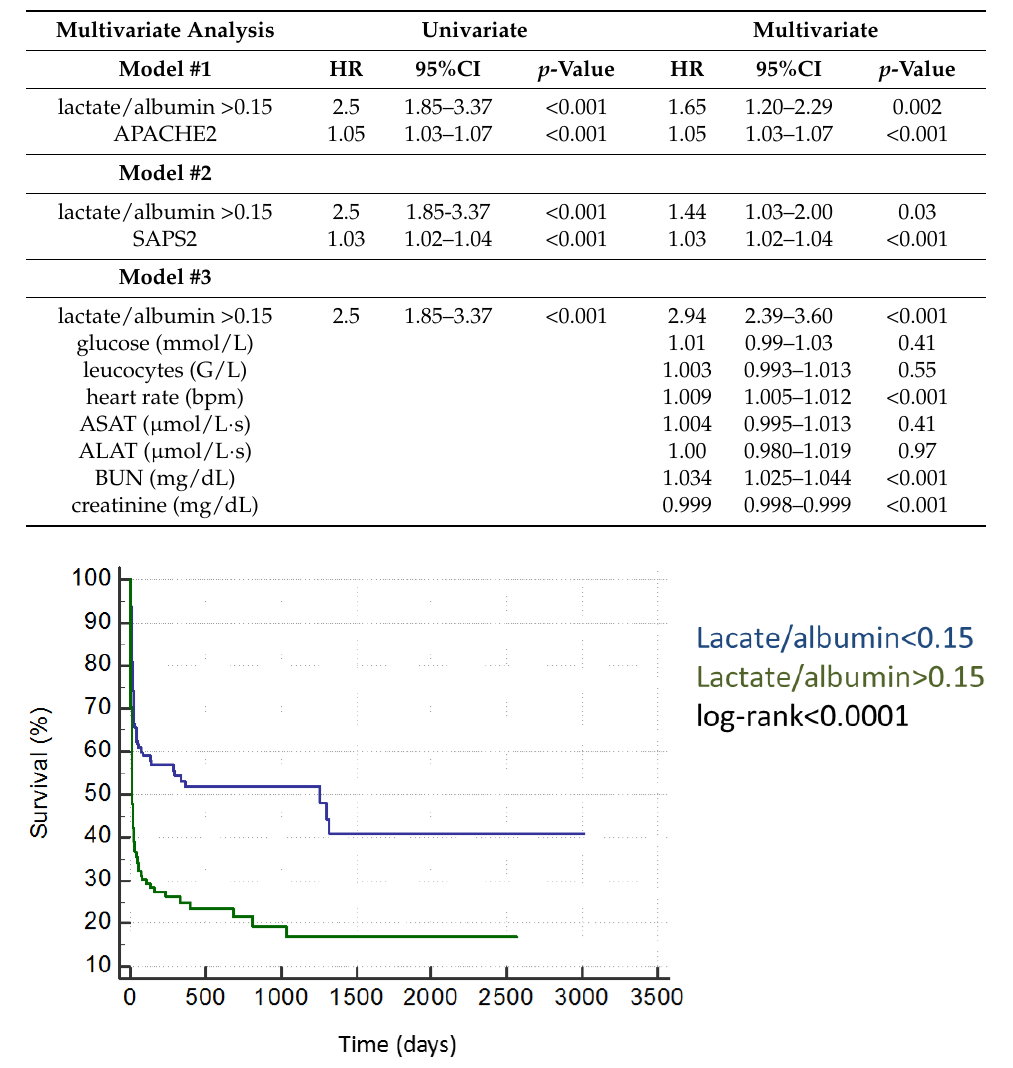
Table 4. A lactate/albumin ratio >0.15 is associated with long-term mortality after correction for several confounders in a multivariate analysis.